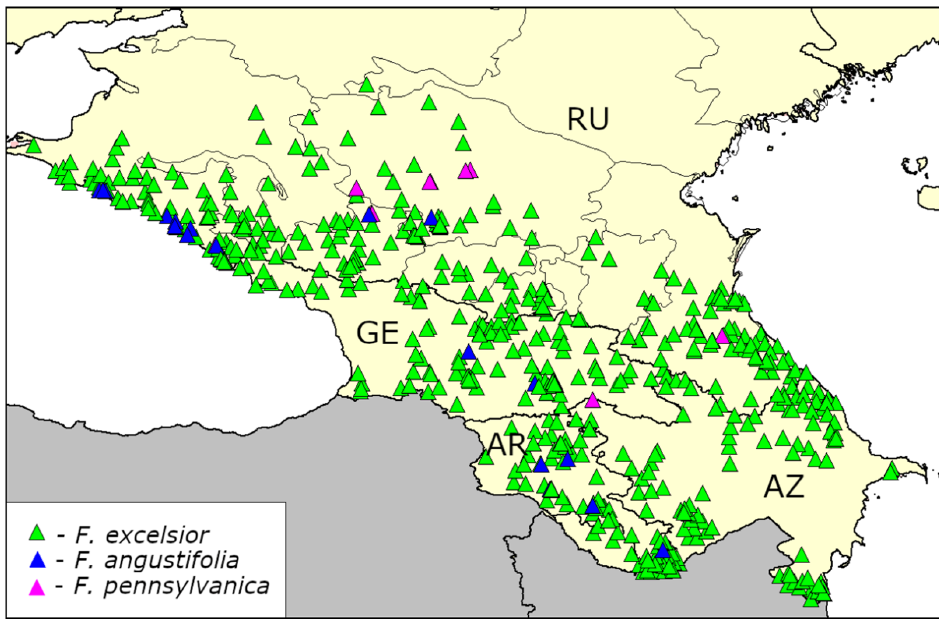
Figure 4. Occurrences of ash trees in the Caucasus according to GBIF [24] and Agroatlas [25]. AR— Armenia; AZ—Azerbaijan; GE—Georgia; RU—Russia.